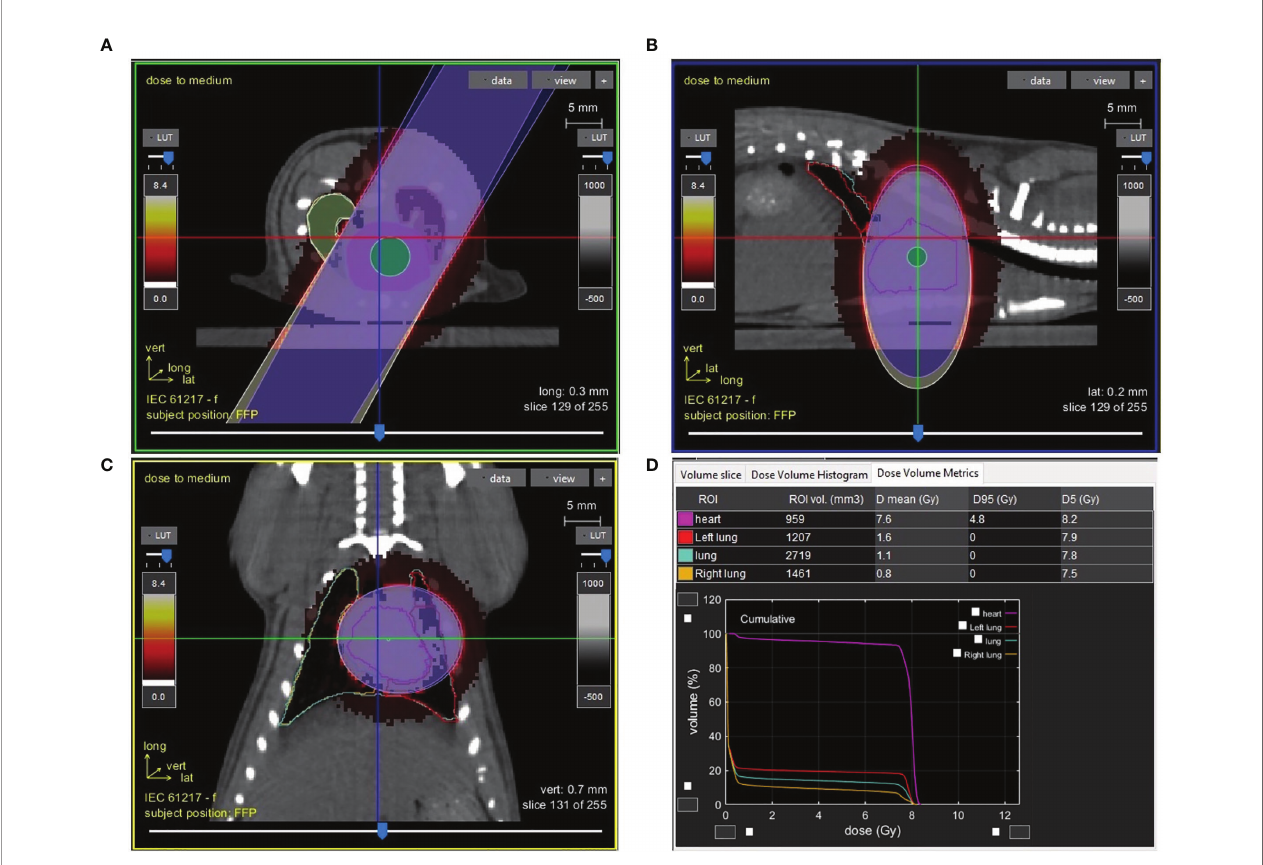
FIGURE 1 | Image guided cardiac irradiation computed tomography images of a representative female rat with a 1.5cm diameter circular collimator plan with radiation dose to isocenter of 8 Gy × 5 fractions with equally weighted parallel opposed beams are shown in the axial (A) , sagittal (B) , and coronal (C) planes. Panel (D) shows the dose volume histogram and metrics demonstrating dose to the heart, left lung and right